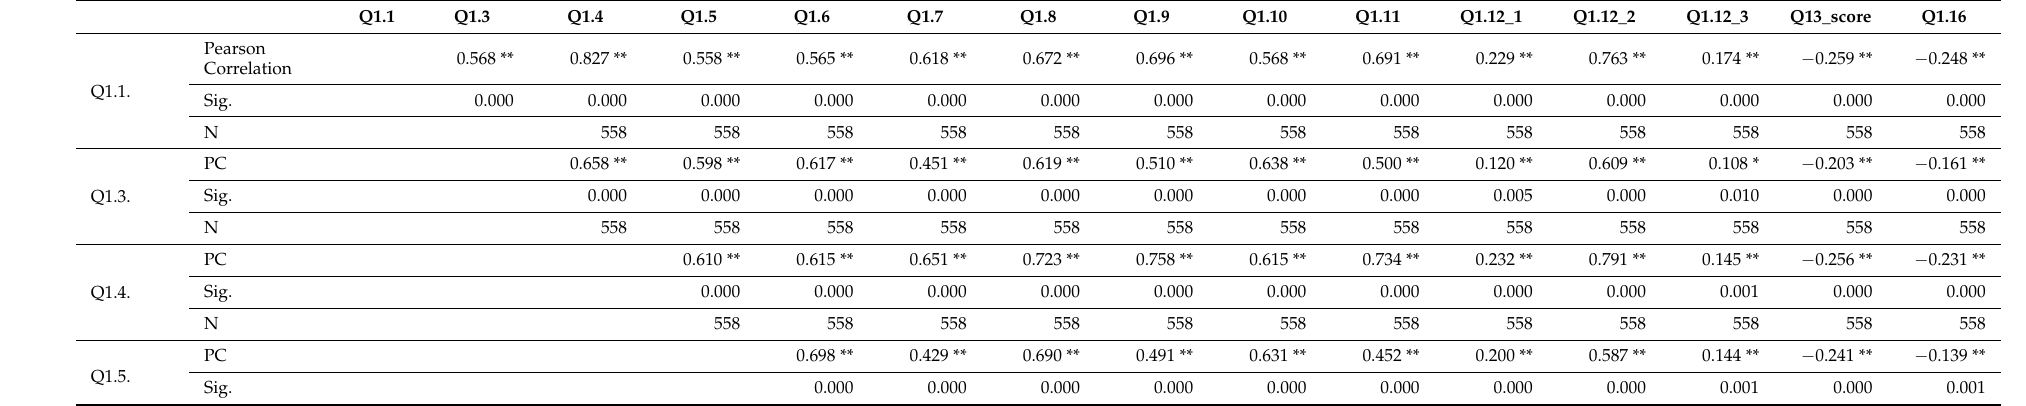
Table A1. Q1.1 In general, how do you evaluate the relationship you have with your father? Q1.3 Thinking about the last year, how many times a week did you do something with your father (talked, watched movies, participated in sports activities, gaming, shopping, etc.)? Q1.4 How close are you to your father? Q1.5 How many hours do you spend in conversations with your father every week? Q1.6 How many times do you talk to your father every week? Q1.7 When your father